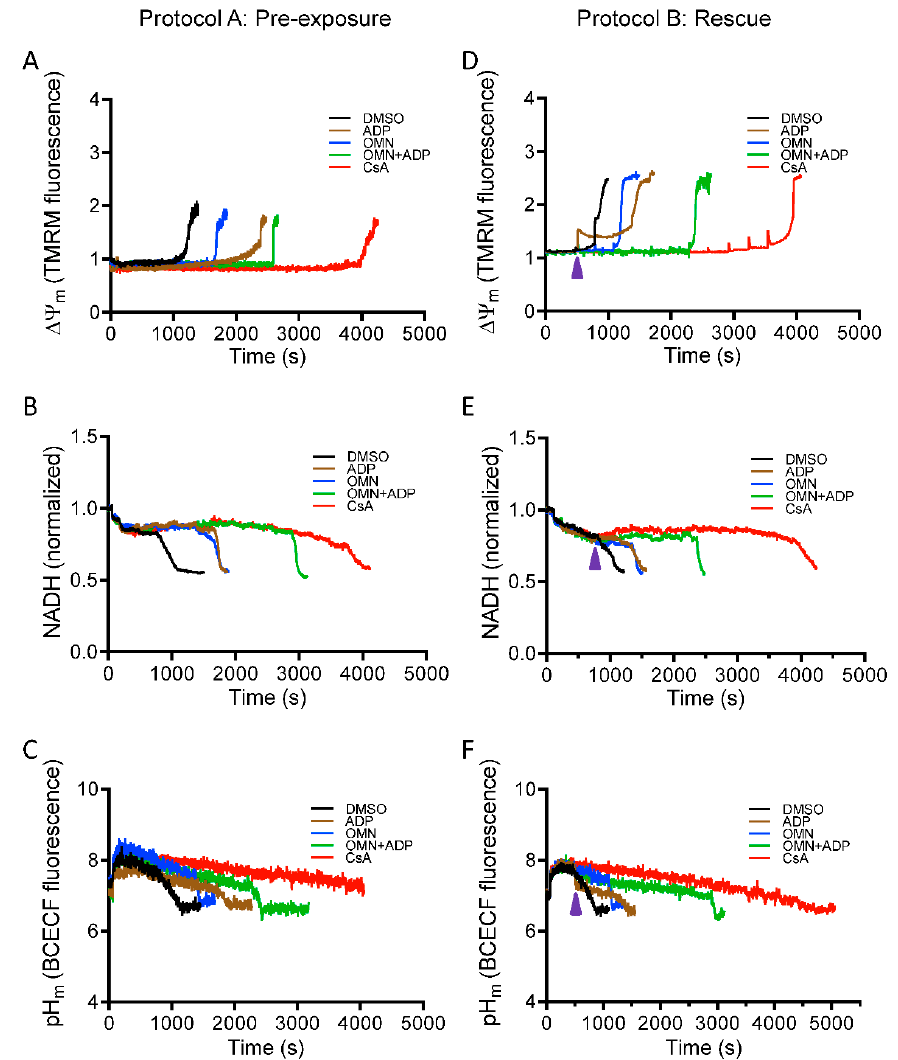
Figure 5. Effect of CsA and AdN on mitochondrial bioenergetics . The bioenergetic responses during Protocols ( A) (left column) and ( B) (right column) were monitored using the ΔΨ m sensitive dye TMRM (tetramethylrhodamine methyl ester perchlorate) ( A , D ), NADH autofluorescence ( B , E ), and pH m -sensitive dye BCECF AM (2 ′ ,7 ′ -Bis-(2-Carboxyethyl)-5-(and-6)-carboxyfluorescein, acetoxymethyl ester AM) ( C , F ). Purple arrowhead indicates time of addition of DMSO (1 µM), ADP (250 µM), OMN (10 µM), OMN+ADP, or CsA (0.5 µM) during Protocol B.